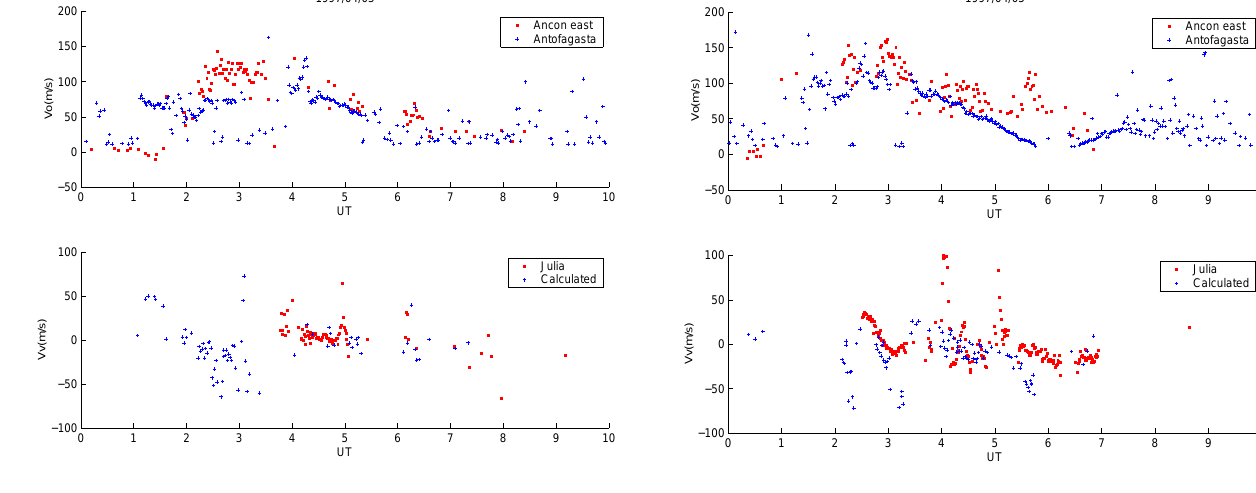
Fig. 9. (c) Same as Fig. 9a for 3 April 1997.